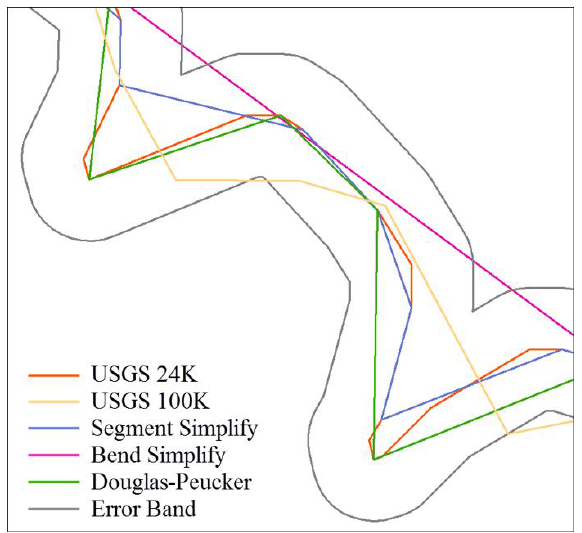
Figure 12. The originals and the outputs of the algorithms.